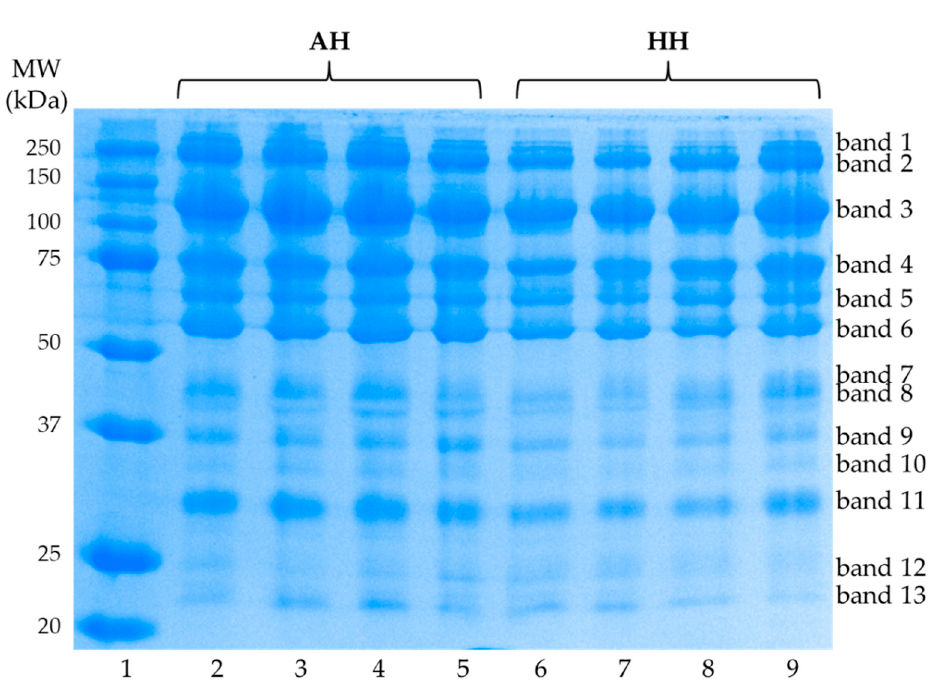
Table 5. Densitometric analysis of electrophoretic bands visualized through the sodium dodecyl sulfate polyacrylamide gel electrophoresis (SDS-PAGE) of globular proteins extracted from egg yolks obtained from commercial hybrid hen (HH) and Nera Atriana laying hen (AH). Band No. 1 MW 2 (kDa)